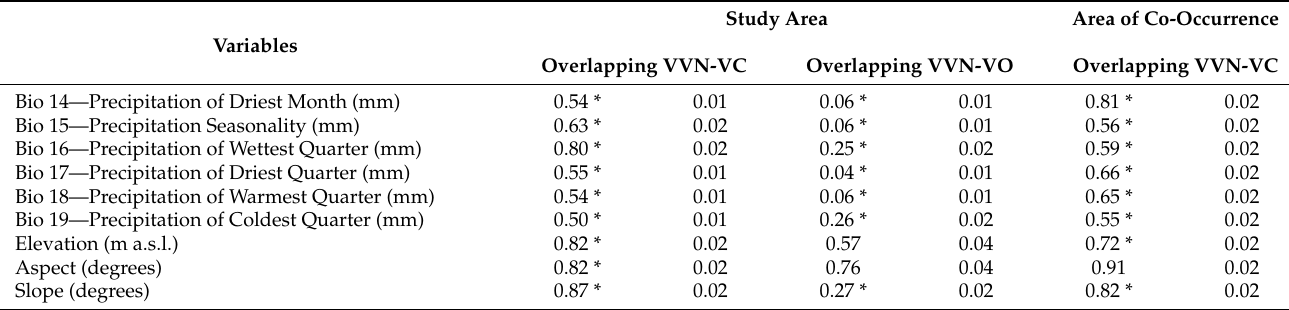
among density functions accordingly to a Wilcoxon test with Bonferroni correction. 3.2. Climatic Niche Analysis in the Areas of Co-Occurrence of V. v. nigrithorax and V. crabro Despite the higher overlap in the climatic variables observed between V. v. nigrithorax and V. crabro in the areas of co-occurrence than at the study area level (Table 1), the realised niches of the two species in the areas of co-occurrence were not totally equal (D = 0.43) (Figure 6). The niche of V. crabro appeared to be slightly shifted toward colder areas, in particular those areas with lower values in Bio 6 (minimum temperature of the coldest months), Bio 9 (mean temperature of the driest quarter) and Bio 11 (mean temperature of the coldest quarter) (Figures S9–S11). In fact, for these variables, the mean of V. crabro is 0.9 ◦ C (Bio 6), 4.2 ◦ C (Bio 9) and 1.2 ◦ C (Bio 11) lower than the mean of V. v. nigrithorax (Table S2). These results are consistent with the results at the study area level. Among the remaining non-bioclimatic variables, a high overlap was observed for the elevation above sea level (72%) and the two derived variables, aspect (91%) and slope (82%) (Tables 1 and S2).